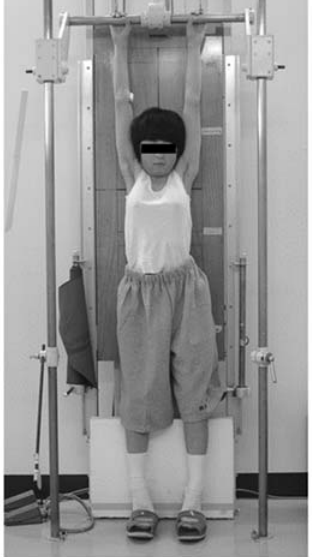
Figure 4. Position of hanging total spine X ‐ ray. Hanging total spine X ‐ ray was taken in a position that the patient is hanging onto the bar, stretching the back, and touching the toes lightly to the floor, not to sway the body under the instruction of making a great effort to stretch their back as much as possible [16] (licensed under CC BY).